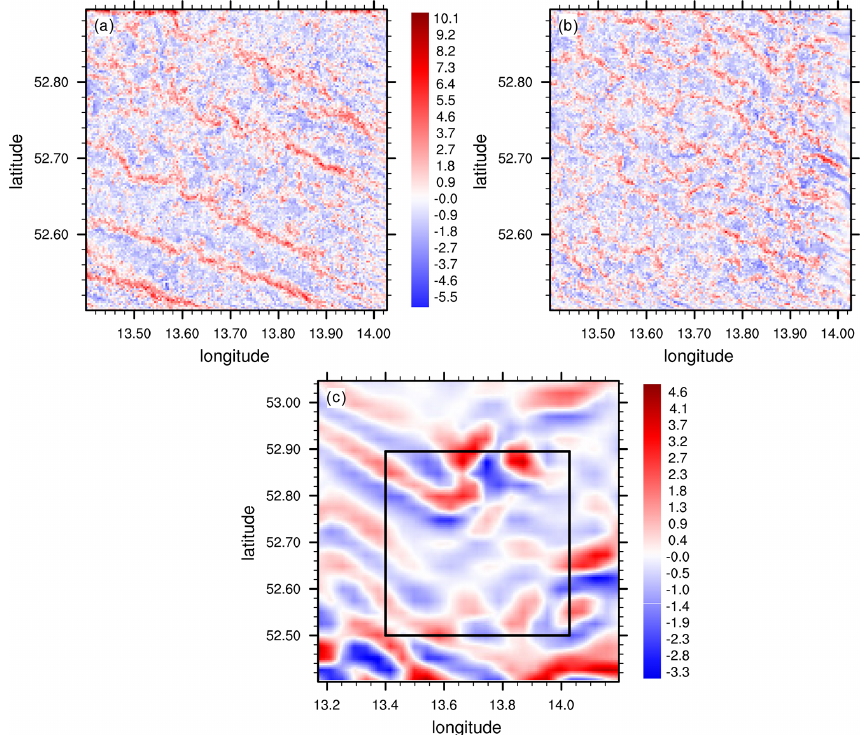
Figure 18. Horizontal cross-sections of the instantaneous vertical velocity component (ms − 1 ) at 12:00UTC at z = 500m from (a) a PALM simulation with heterogeneous lateral and top boundary values given (LOD = 2), (b) a PALM simulation with homogeneous boundary values given (LOD = 1), and (c) a COSMO simulation. The black box in panel (c) indicates the location of the nested PALM domain within COSMO. The horizontal grid spacing in COSMO is 0 . 025 ◦ . Please note that, for sake of comparison, the PALM axes are plotted in ( ◦ ) as well, even though PALM uses Cartesian